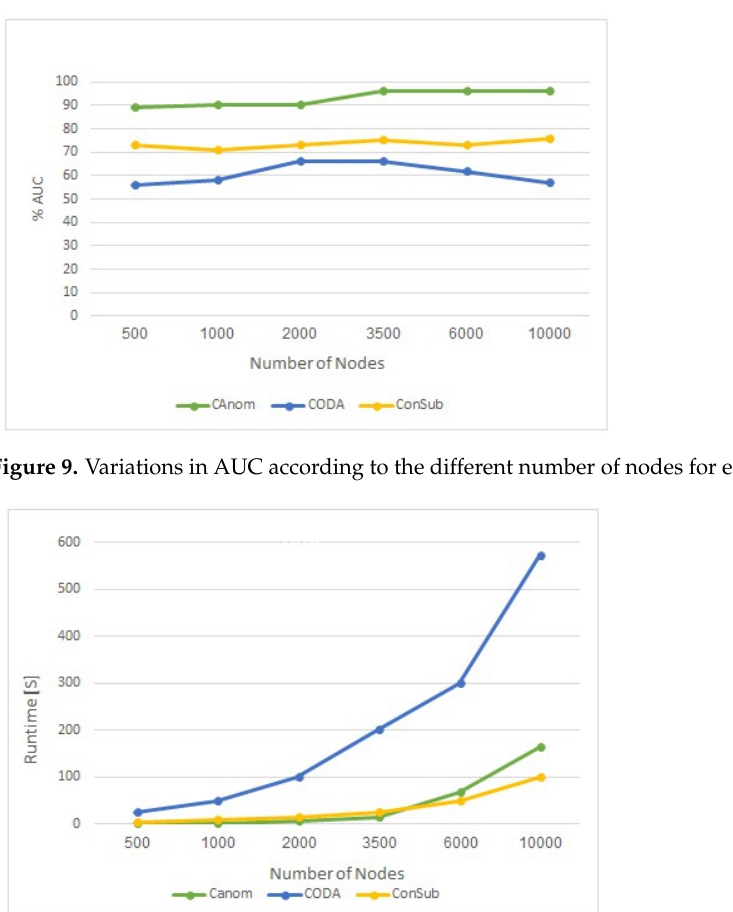
Figure 10. Variations in runtime according to the different number of nodes for each of the tested